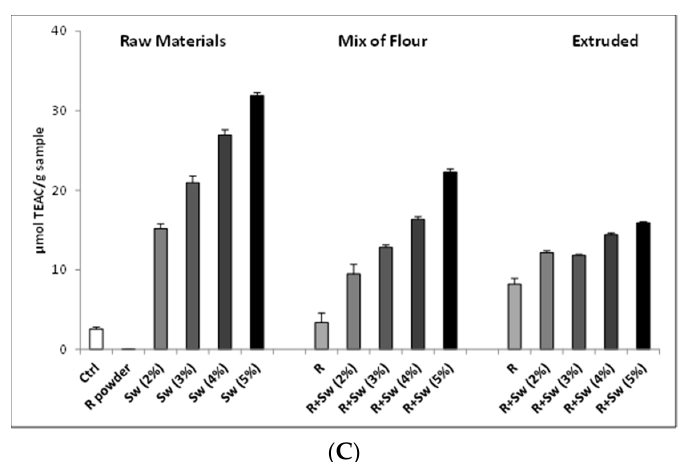
Figure 3. Trolox equivalent antioxidant capacity ( TEAC) values for raw materials, mix of flour and extruded snacks with ( A ) 1% Garlic (G), ( B ) 0.5% Basil (B) + 3% Tomato (T), and ( C ) 0.5% Rosemary (R) powders and increasing concentration of seaweed extract (Sw). Ctrl consists in rye mix. Data are